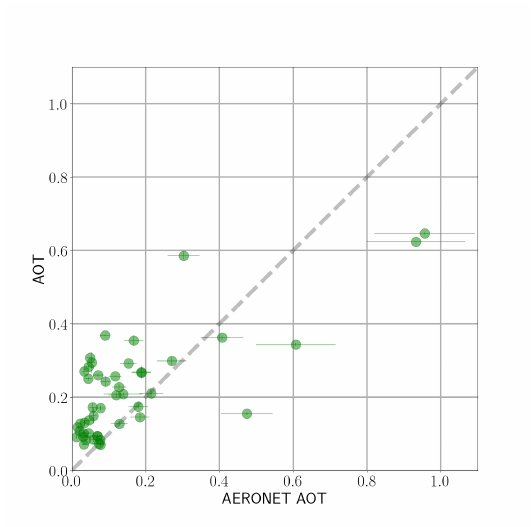
Figure 1. DESIS versus AERONET AOT (550 nm) (green dots). The 1:1 line is represented by a grey dashed